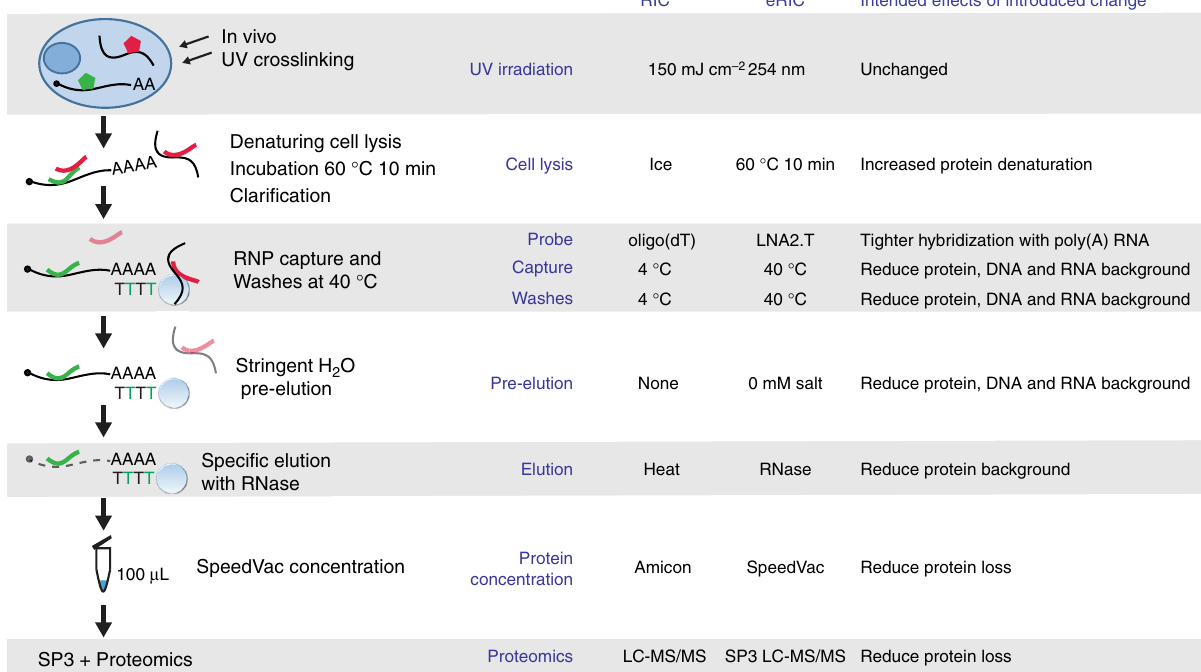
Fig. 1 Schematic representation of the eRIC method. RBPs are crosslinked to RNAs in vivo by irradiating cells with 254 nm UV light. Crosslinked proteins are isolated under denaturing conditions employing a LNA-modi fi ed probe and stringently washed under high temperature conditions using high salt concentrations fi rst (to eliminate contaminants primarily based on hydrophilic protein – protein interactions) and low salt concentrations afterwards (to eliminate contaminants based on nucleic acid base pairing). Captured proteins are then eluted with RNase, concentrated to 100 μ L to apply the Single ‐ Pot Solid ‐ Phase ‐ enhanced Sample Preparation protocol (SP3, see main text: Analysis of RBPs identi fi ed by RIC versus eRIC), and identi fi ed by mass spectrometry. A comparison with the previous RIC protocol is included on the right. Green pentagon/line: native/denatured RBP; in red: contaminant protein. Black line with stretch of As: poly(A) RNA. Black line: contaminating non-poly(A) RNA/DNA. Light blue circle with stretch of T: capture probe coupled to magnetic beads (black and green Ts symbolize the alternation of DNA and LNA nucleotides; note that capture probe has actually 20 bases). LC-MS/MS: liquid chromatography – tandem mass